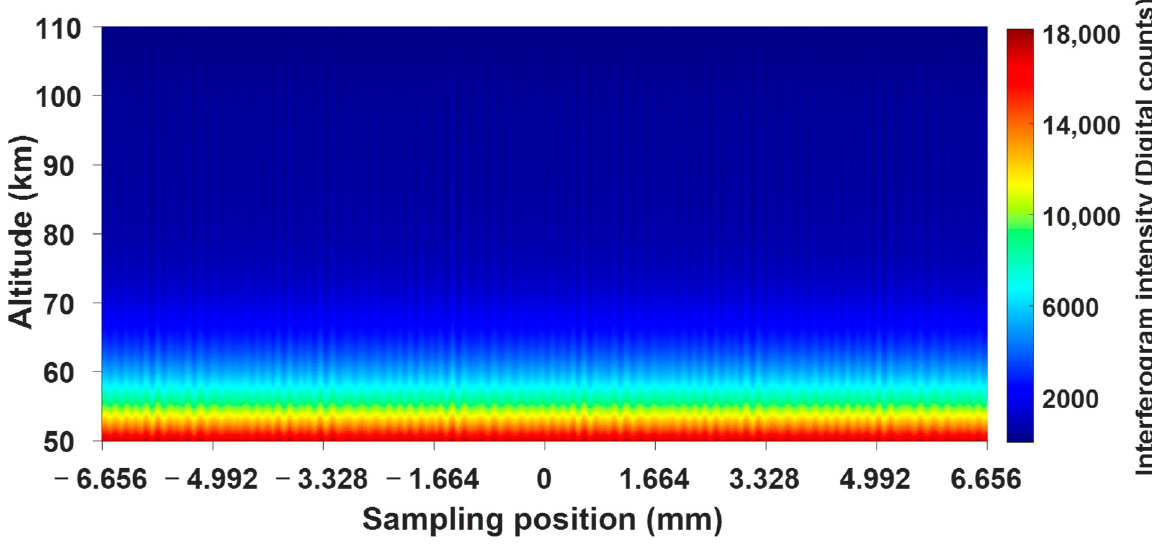
Figure 7. Spectral characteristics of the filter and target airglow. Since the observation tracks of the two FOV were consistent, the simulation was car- ried out for only one FOV. The simulated raw interferogram is shown in Figure 8. The horizontal direction of the detector is the interference dimension, which characterizes the interference intensity under different optical path differences. The vertical direction is the spatial dimension, which represents the interference intensity at different altitudes of tan- gent points. Affected by background radiation, the interferogram intensity increased sig- nificantly with the decreasing altitude. The MWII observed four emission lines simulta- neously, so the interference fringes exhibited the phenomenon of multi-frequency cou- pling. Figure 9 shows the interference fringes at the tangent altitude of 60 km.